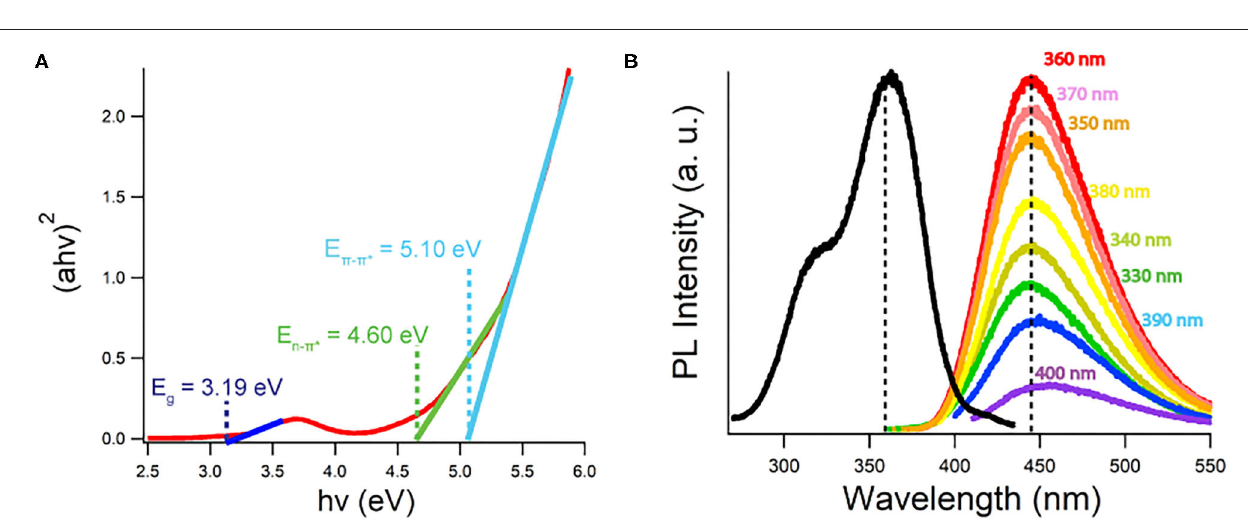
quantum yield and electroluminescent device efficiencies, as well as achieving strong PL efficiencies. Linear extrapolations to the x-intercept from the low energy side of peaks in the Tauc plots yields specific absorption energies. Tauc plots were constructed for all CQDs, where information gained is summarized in Table 1 . The lowest energy absorption in the visible range is due to the band gap of the CQDs. No large deviations from the optical band gap are observed indicating that the state responsible for emission, is shared among all CQDs, despite carbon core state differences. An intrinsic semiconductor E g is illustrated